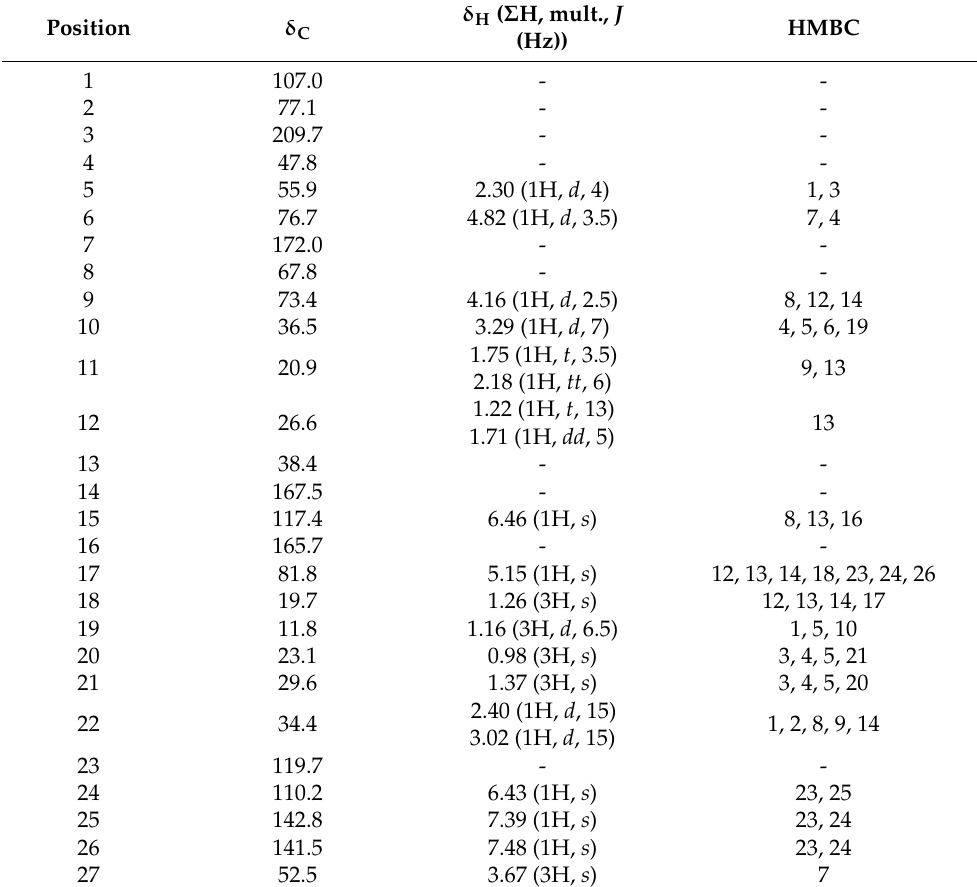
Table 1. 13 C-NMR, 1 H NMR and HMBC Spectral Data of Compound 1 in CDCl 3 . Position δ C